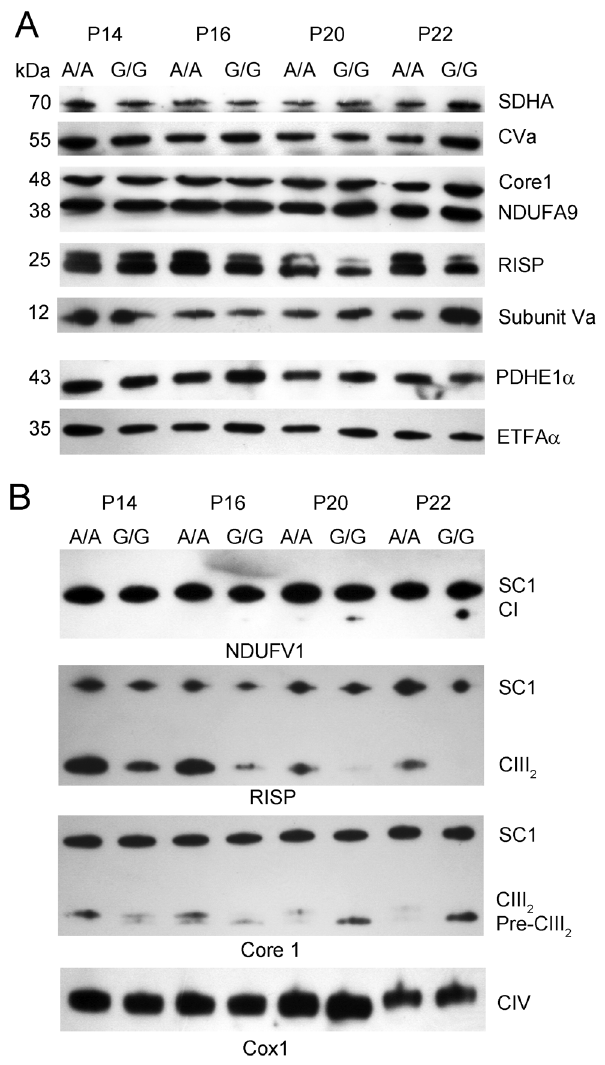
Figure 2. Age dependent decrease of RISP in young Bcs1l G/G mice. A. Subunits of all complexes were assessed after SDS PAGE of isolated mitochondria from Bcs1l G/G (G/G) and wild type (A/A) young mice using the following antibodies; SDHA (CII), CVa (CV), Core1 (CIII), NDUFA9 (CI), RISP (CIII), and Subunit Va (CIV). Pyruvate dehydrogenase (PDHE1 a ) and electron-transfer-flavoprotein, alpha polypeptide (ETFA a ) were used as loading controls. B. Supercomplexes in homozygous and wild type young mice were investigated with BNGE and Western blot using antibodies detecting subunits NDUFV1, RISP, Core1 and subunit Cox1 (CIV).